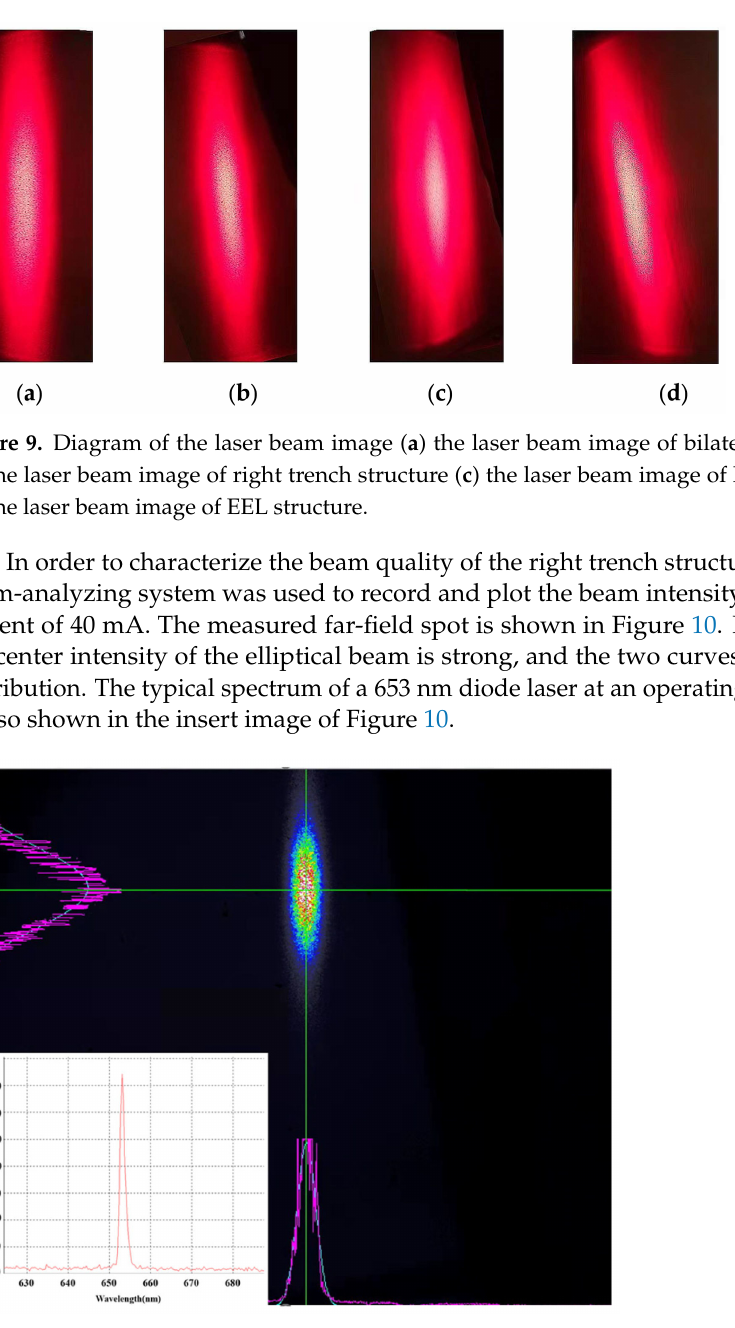
Figure 10. The far-field spot and the typical spectrum in left corner at an operating current of 40